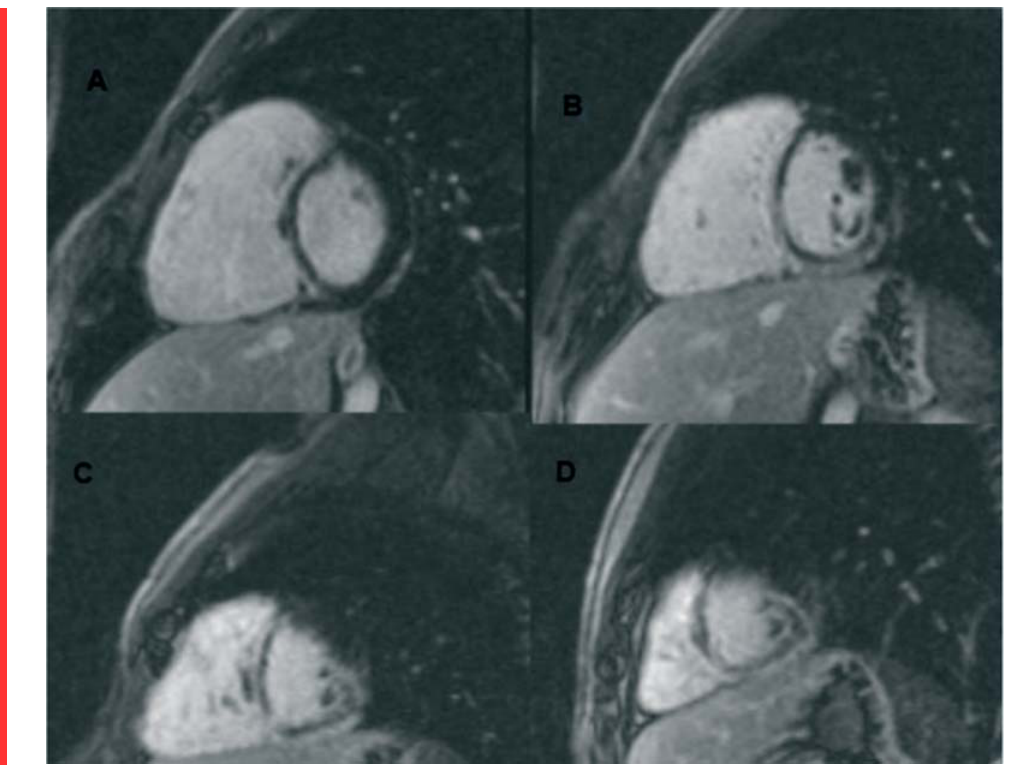
Figure 8. Cardiac magnetic resonance imaging of a patient with extensive AC. Short axis view from base (upper left) to apex (lower right) demonstrating extensive fibrosis as evidenced by delayed gadolinium enhancement in most of right ventricular wall (only sparing a small infero-septal area), interventricular septum and the epicardium of the left ventricular inferior wall. This patient underwent cardiac transplantation for severe